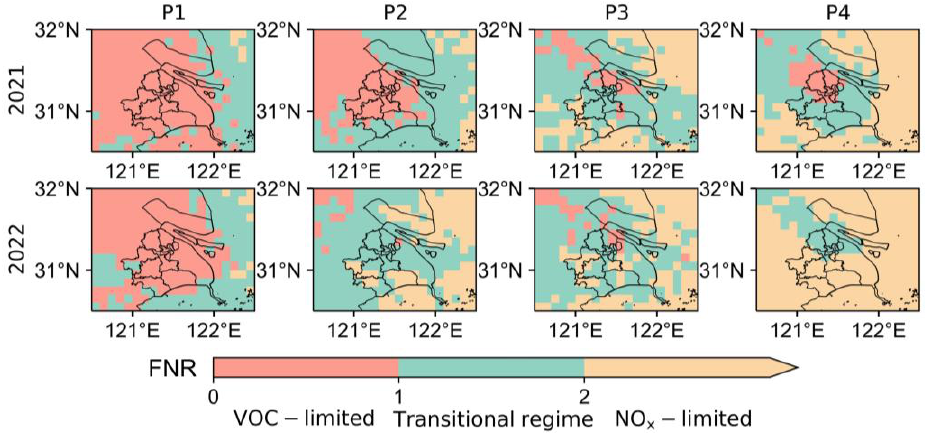
Figure 8. The spatial distributions of FNR in Shanghai from P1 to P4 in 2021 and 2022.